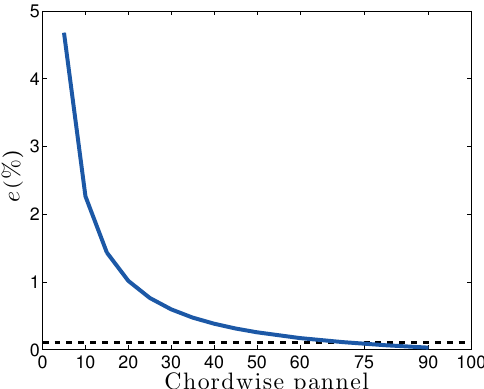
Figure 6. Vortex Lattice Method (VLM) convergence with the number of chordwise panels.